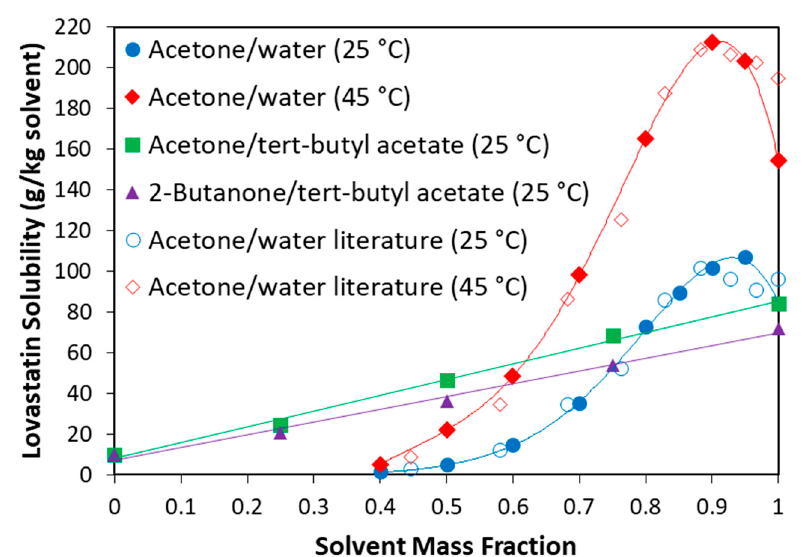
Figure 3. Comparison of measured lovastatin solubility in various mixtures of acetone/water, acetone/tert-butyl acetate, and 2-butanone/tert-butyl acetate at 25 °C in addition to measured lovastatin solubility in various mixtures of acetone/water at 45 °C. Literature lovastatin solubility in various acetone/water mixtures at both 25 and 45 °C is also included for comparison [47] . The measured values have error bars, which are obscured by the marker points, as the standard deviations are extremely small.